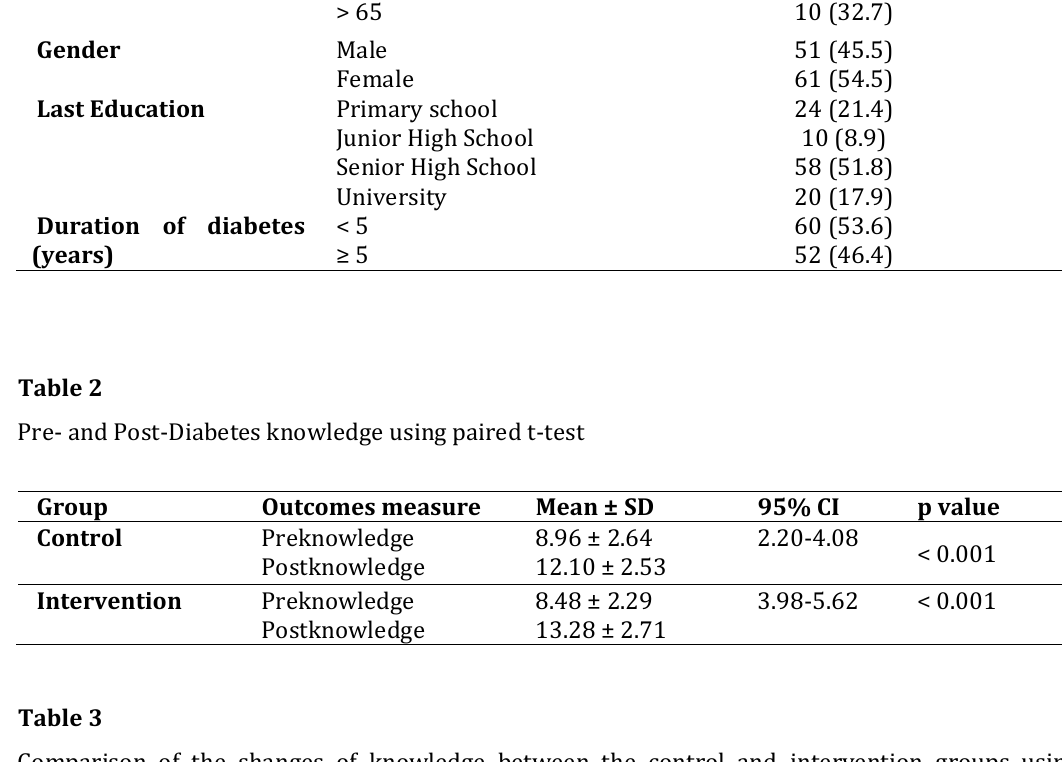
Comparison of the shanges of knowledge between the control and intervention groups using independent